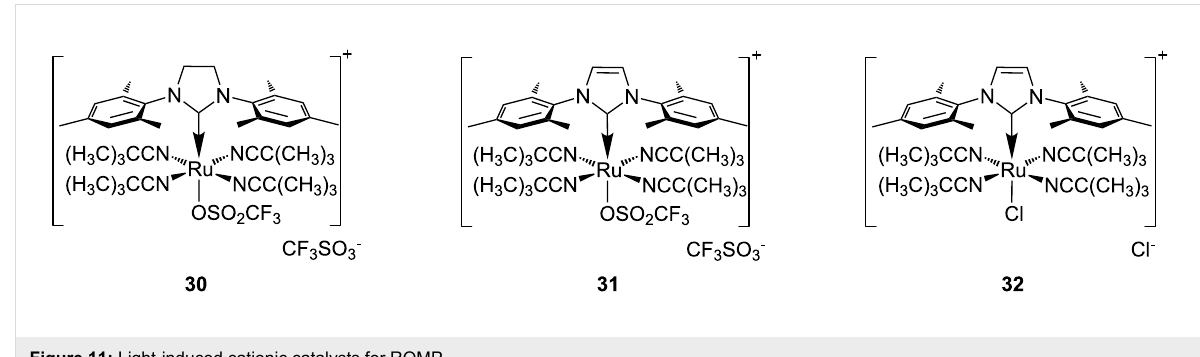
Figure 11: Light-induced cationic catalysts for ROMP.